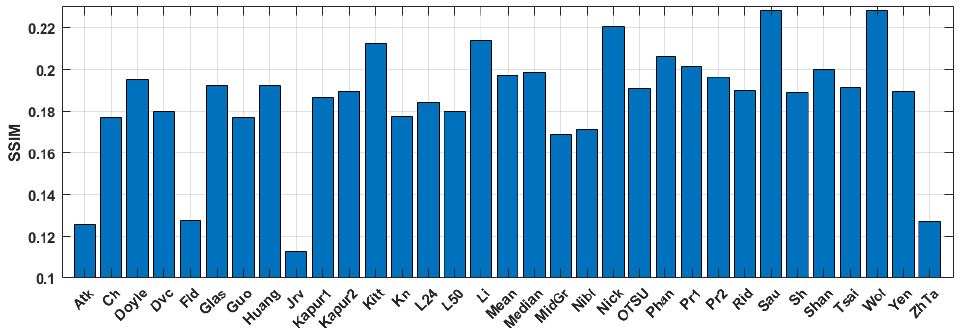
Figure 5. Average SSIM values for the binary amplitude inline Fresnel holograms.